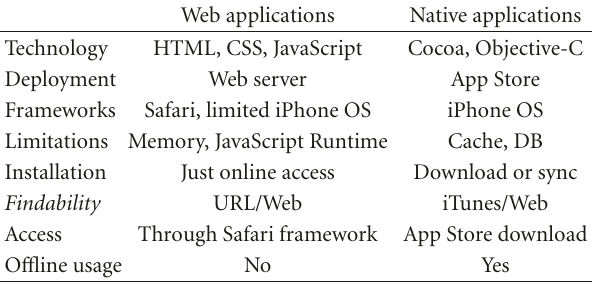
Table 2: Comparison of main technical characteristics between Web and native applications in the developer